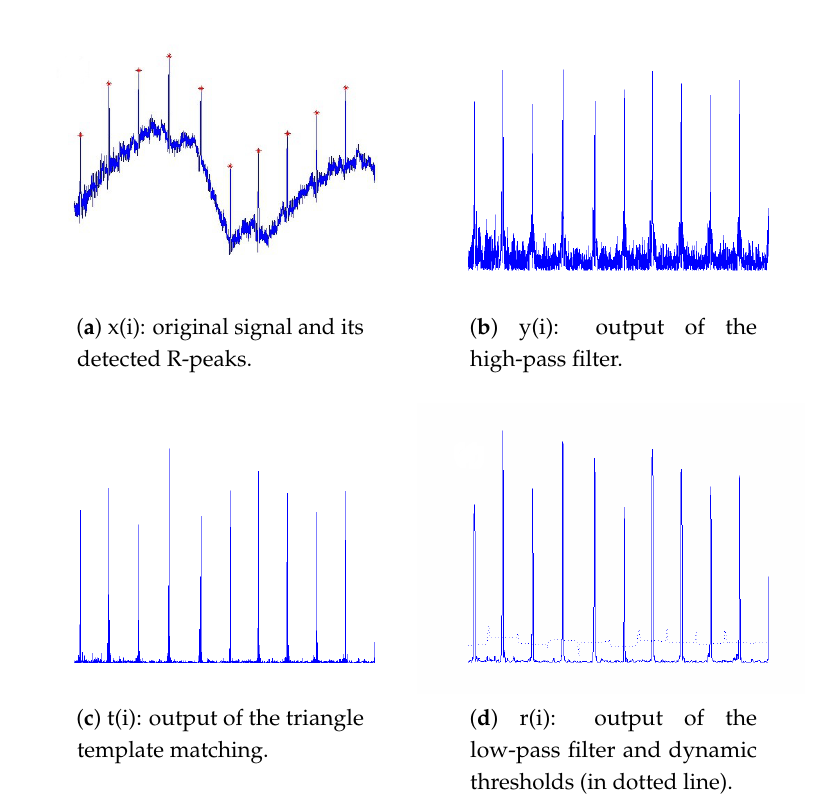
Figure 2. Signals at different steps in the